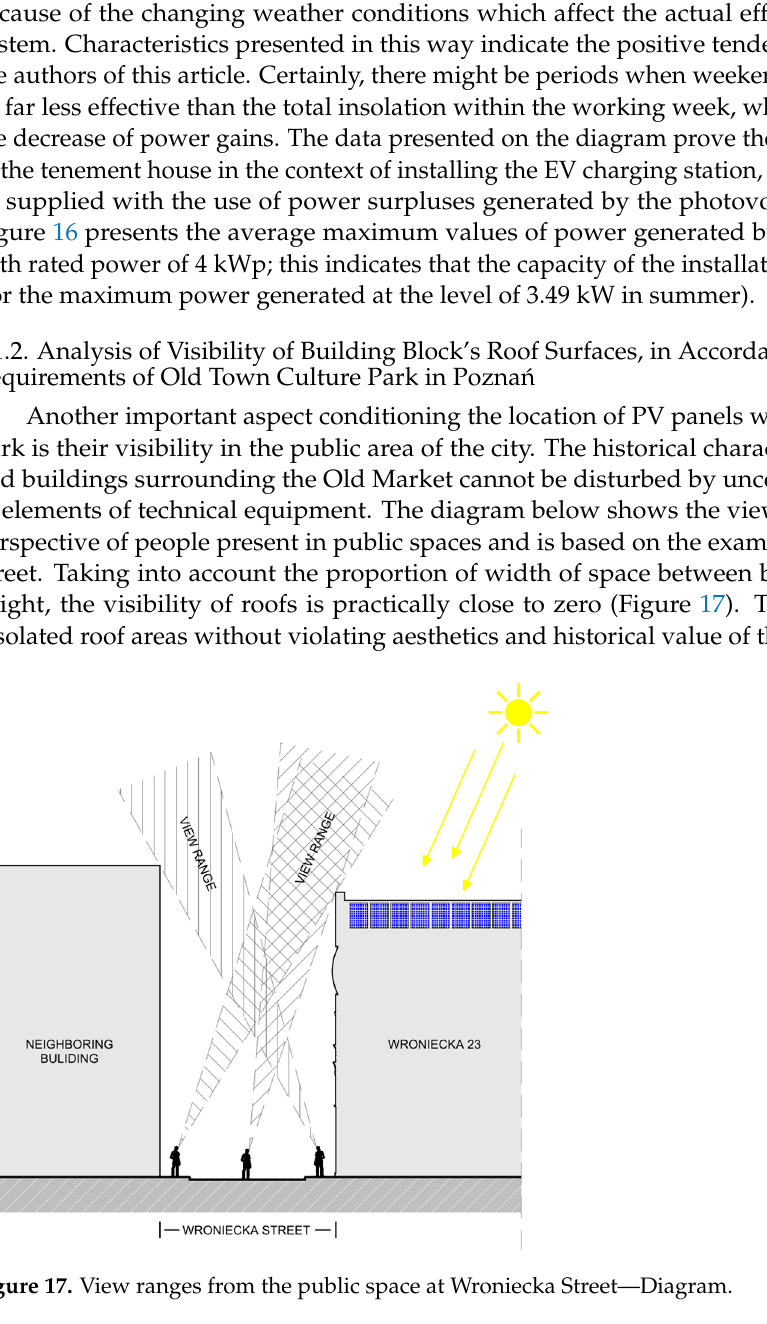
Figure 18. Roofs visible from the public space surrounding the building block. 3.2. EV Energy Consumption Measurement of energy consumption in electric drive was conducted in accordance with RDC procedures (Real Driving Conditions), with initial battery charge status 100% (according to the app SKODA CONNECT linked with SKODA CITIGO e IV). While driv- ing, the following parameters were recorded: recording time [s], vehicle’s speed [km/h], rotational speed of the engine [rpm], charge/discharge current in a high-voltage battery [A], current value on electric engine [A], tension value on electric engine [V], power taken/recovered from the high-voltage battery [W], state of charge of the battery (SOC) [%], EV engine torque [Nm]. Then, based on the author’s work on driving parameters, the requirements to be met during driving tests were stipulated in accordance with RDE pro- cedures (Real Driving Emission); it led the researchers to calculating the EV power de- mand at selected stages of the test. The RDC test was divided into three sections with